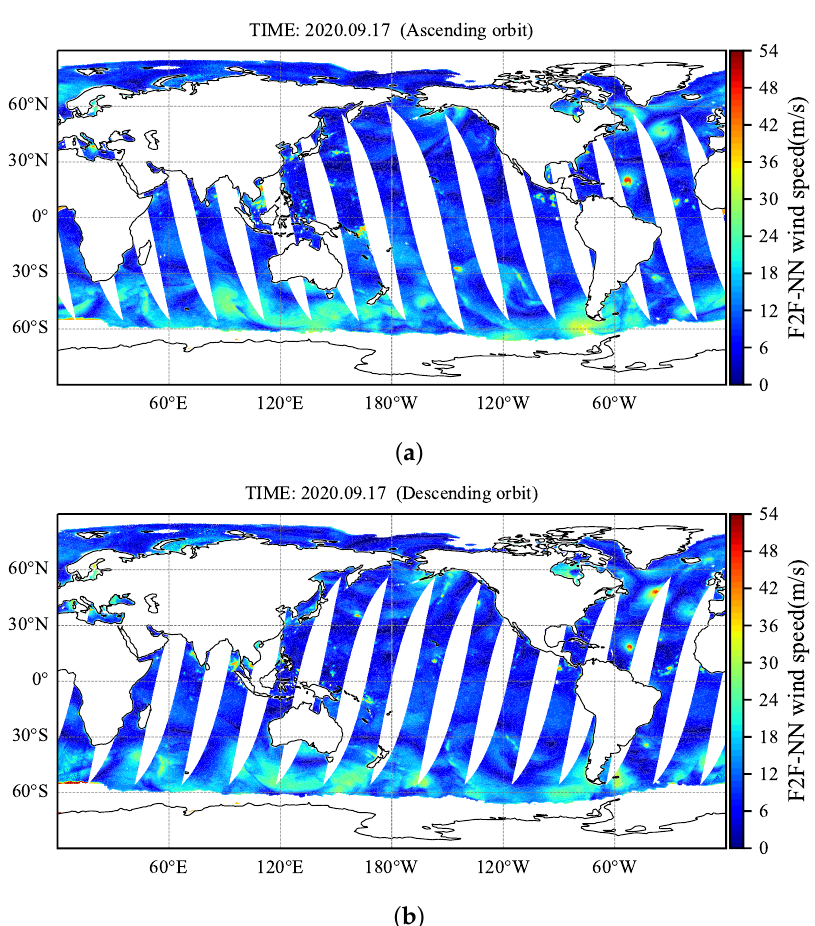
Figure 7. ( a ) is the wind field obtained by F2F-NN from the data collected in the ascending orbit of the FY-3D MWRI on 17 September 2020, and ( b ) is the retrieval result of the descending orbit.